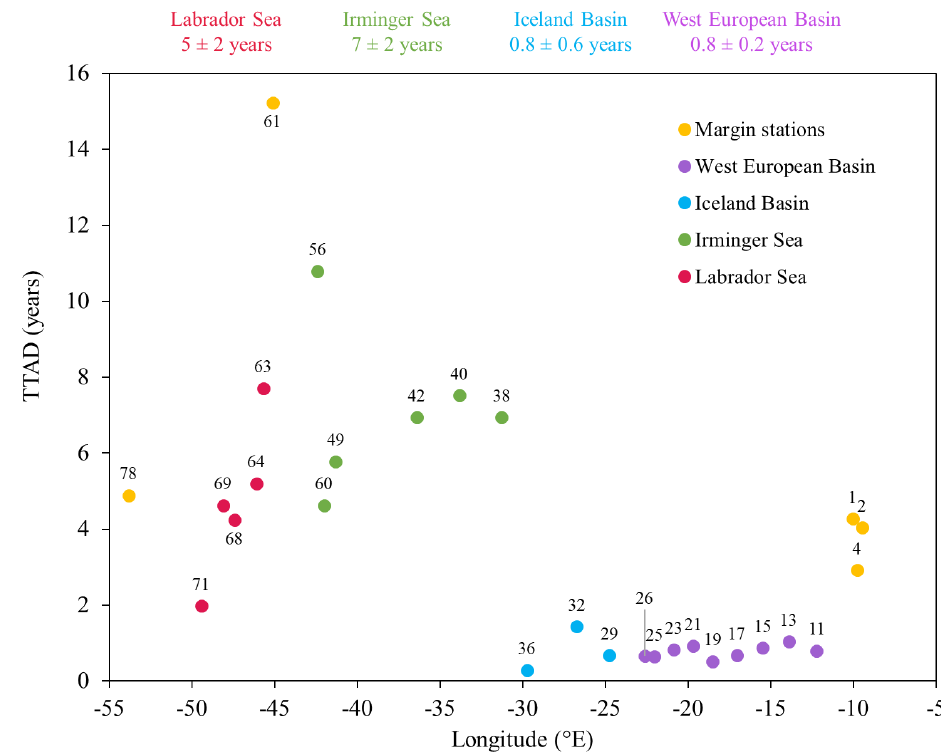
Figure 6. Plot of dissolved Fe (DFe) turnover times relative to atmospheric deposition (TTADs) calculated from soluble Fe contained in aerosols estimated from a two-stage sequential leach (UHPW, then 25% HAc; Shelley et al., 2018). Note that numbers on top of points represent station numbers and that the color coding refers to different regions with margin stations in yellow, the West European Basin in purple, the Iceland Basin in blue, the Irminger Sea in green, and the Labrador Sea in red. The numbers on top of the plot represent TTADs averaged for each oceanic basin and their standard